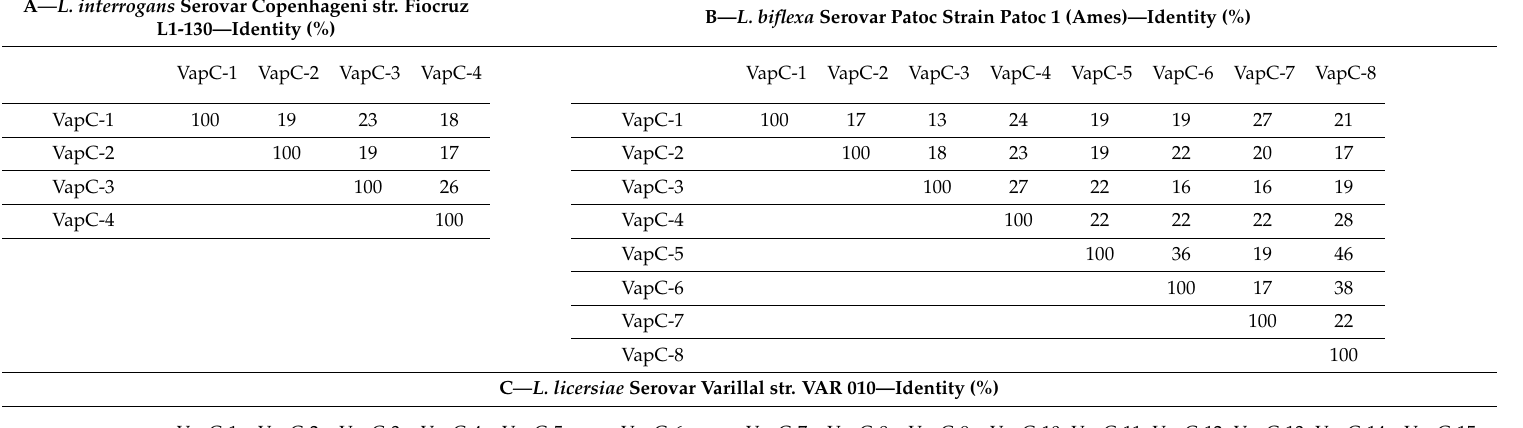
Table 1. Amino acid sequence identities of VapCs within the same Leptospira